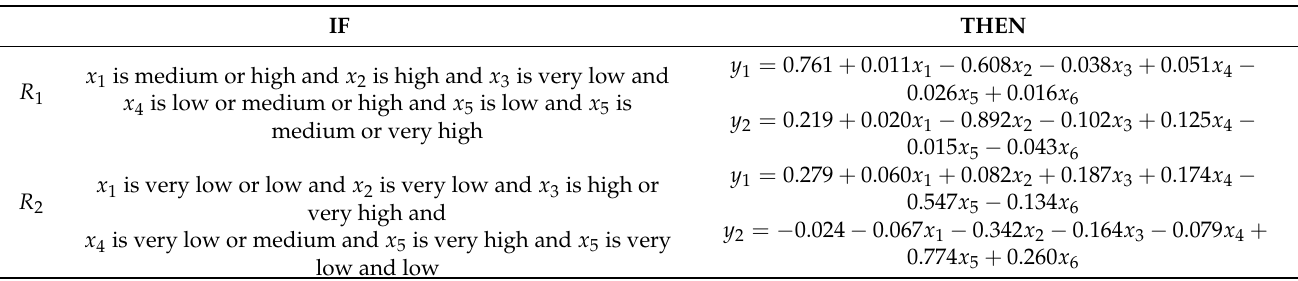
Table 12. Rule description for the Monk2